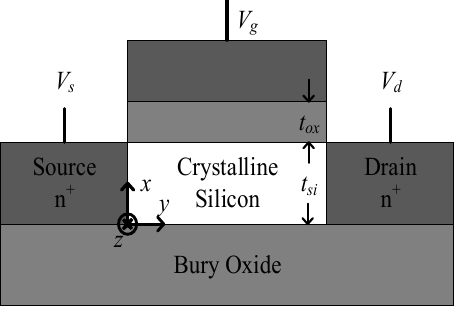
Figure 1. x-y cross section of silicon-on-insulator (SOI) MOSFETs.